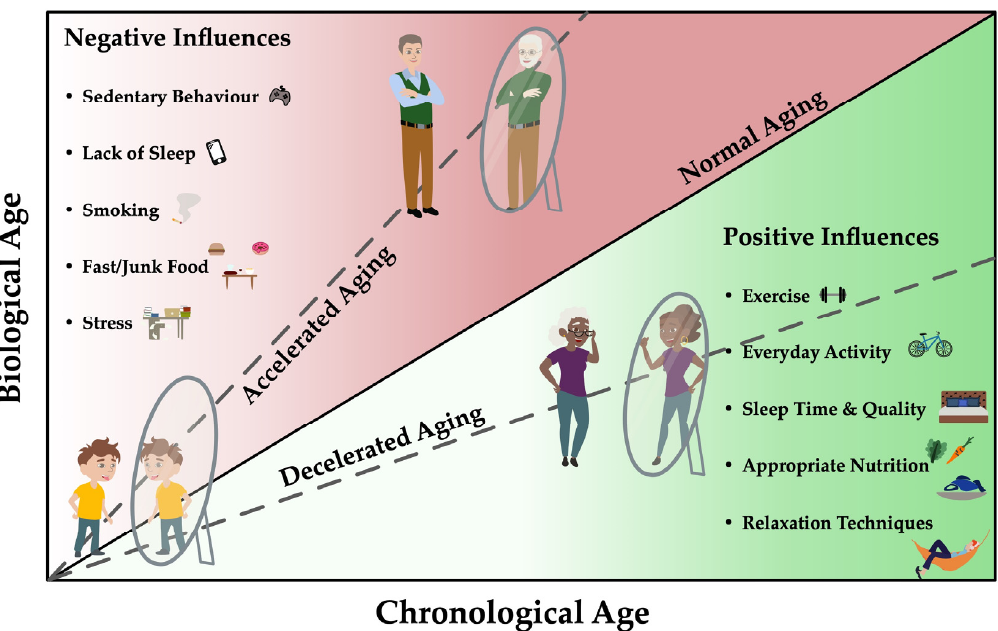
Figure 1. Biological age correlates with the chronological age of a person and depends, among other things, on genetic predisposition, phenotypic changes and epigenetic changes. Nutritional, environmental, psychosocial and other lifestyle (exercise, weight) factors have the potential to both delay and accelerate the aging process and thus modulate risk of diseases. Specific biomarkers could serve as biological age predictors for risk assessment of age-specific diseases and thus influence the aging process positively as well as negatively. This could allow the detection of differences in the risk of age-related diseases for individuals of the same chronological age and identify pathways that have the potential to target these negative epigenetic changes.